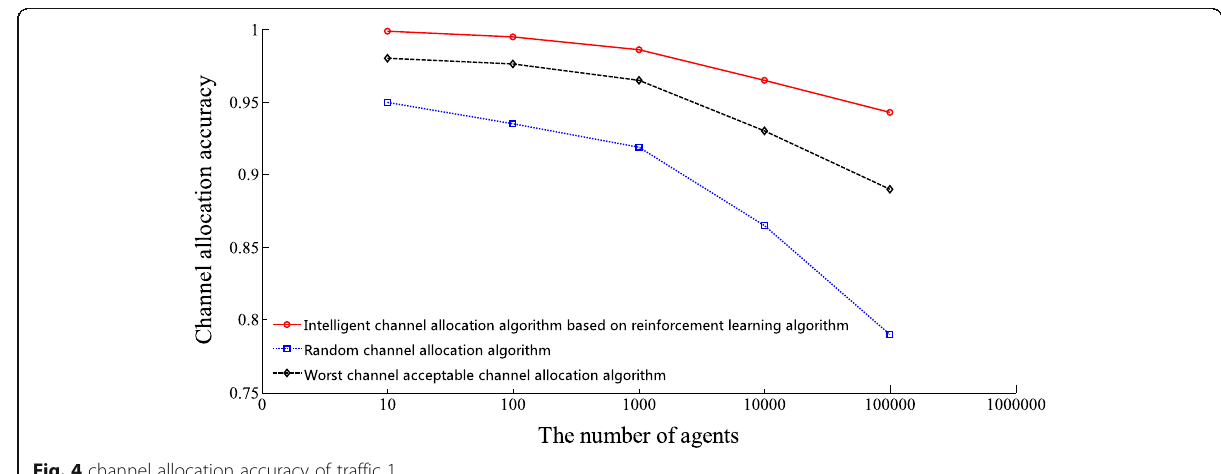
Fig. 4 channel allocation accuracy of traffic